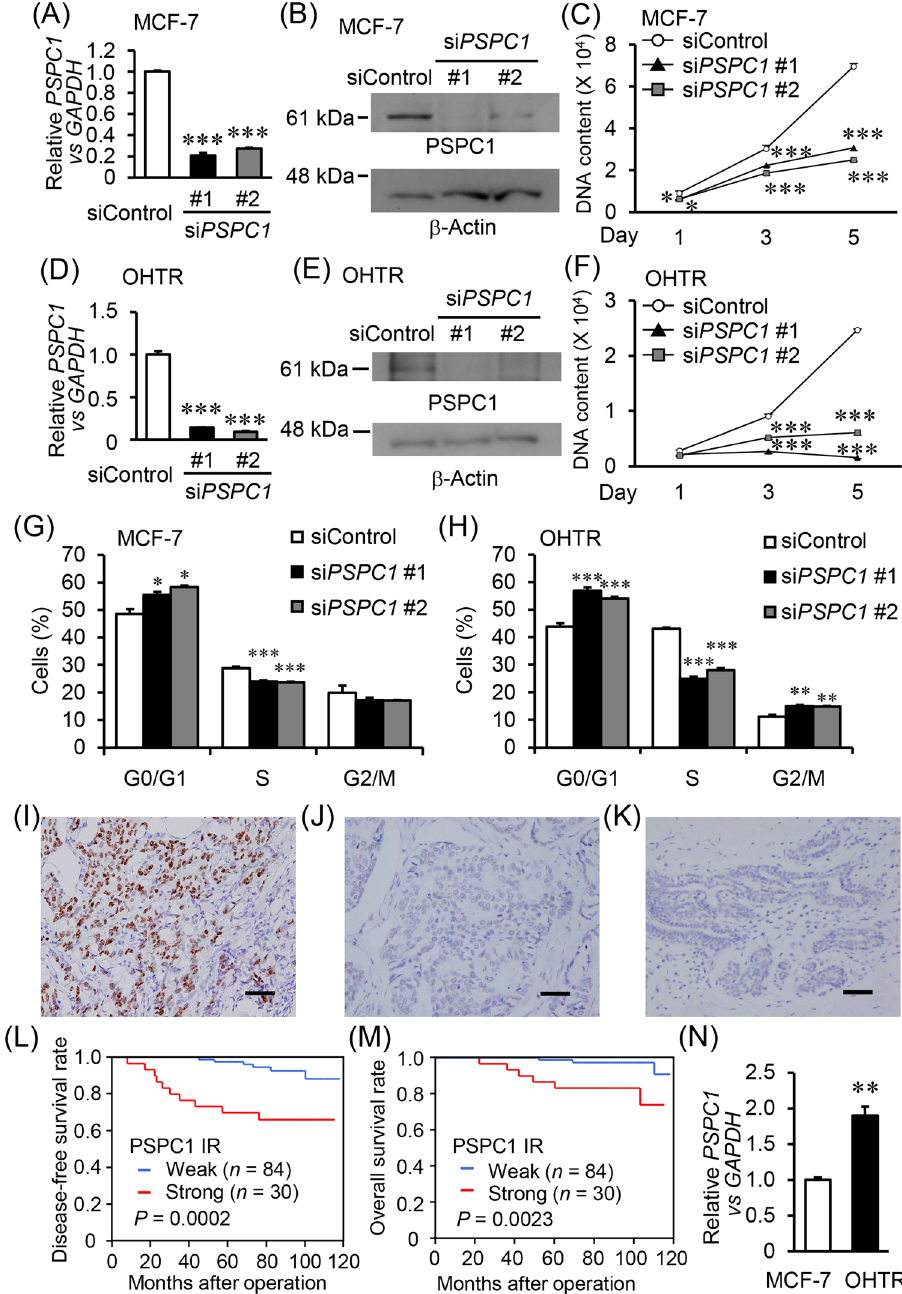
Figure 1. PSPC1 is associated with ER-positive breast cancer growth and poor prognosis for ER-positive breast cancer patients. ( A , D ) PSPC1 mRNA levels in MCF-7 ( A ) and its 4-hydroxytamoxifen (OHT)-resistant derivative OHTR ( D ) cells transfected with control (siControl) or PSPC1-specific (si PSPC1 #1 and #2) siRNAs (10 nM) analyzed by qRT-PCR. Relative PSPC1 mRNA level was normalized to GAPDH mRNA level in each sample and presented as mean fold change ± SEM compared with siControl ( n = 3). ( B , E ) PSPC1 protein levels in MCF-7 ( B ) and OHTR ( E ) cells transfected with indicated siRNAs (10 nM) analyzed by Western blotting. β-Actin was used as a loading control. Unprocessed original scans of the blots are shown in Supplementary Fig. S3. ( C , F ) DNA assay for MCF-7 ( C ) and OHTR ( F ) cells treated with the indicated siRNAs (10 nM). Data are presented as mean value ± SEM ( n = 5). ( G , H ) Cell-cycle analysis in MCF-7 ( G ) and OHTR ( H ) cells after treatment with indicated siRNAs using flow cytometry. Percentages of cell populations in G0/G1-, S-, and G2/M-phases are shown. Data are presented as mean value ± SEM ( n = 3). Original flow cytometry data are shown in Supplementary Fig. S4. ( I – K ) Representative images of ER-positive breast cancer tissue sections with strong ( I ) and weak ( J ) PSPC1 immunoreactivity (IR), and benign breast ducts ( K ). Scale bar, 50 μm. ( L , M ) Kaplan–Meier plots for disease-free ( L ) and overall ( M ) survivals of ER-positive breast cancer patients with weak and strong PSPC1 IR ( n = 84 and 30, respectively). ( N ) PSPC1 mRNA levels in MCF-7 and OHTR cells analyzed by qRT-PCR. Relative PSPC1 mRNA level was normalized to GAPDH mRNA level in each sample and presented as mean fold change ± SEM ( n = 3). * P < 0.05; ** P < 0.01; *** P < 0.001, two-way ANOVA performed in ( A , C , D , F , G , H ). ** P < 0.01, Student’s t -test performed in ( N